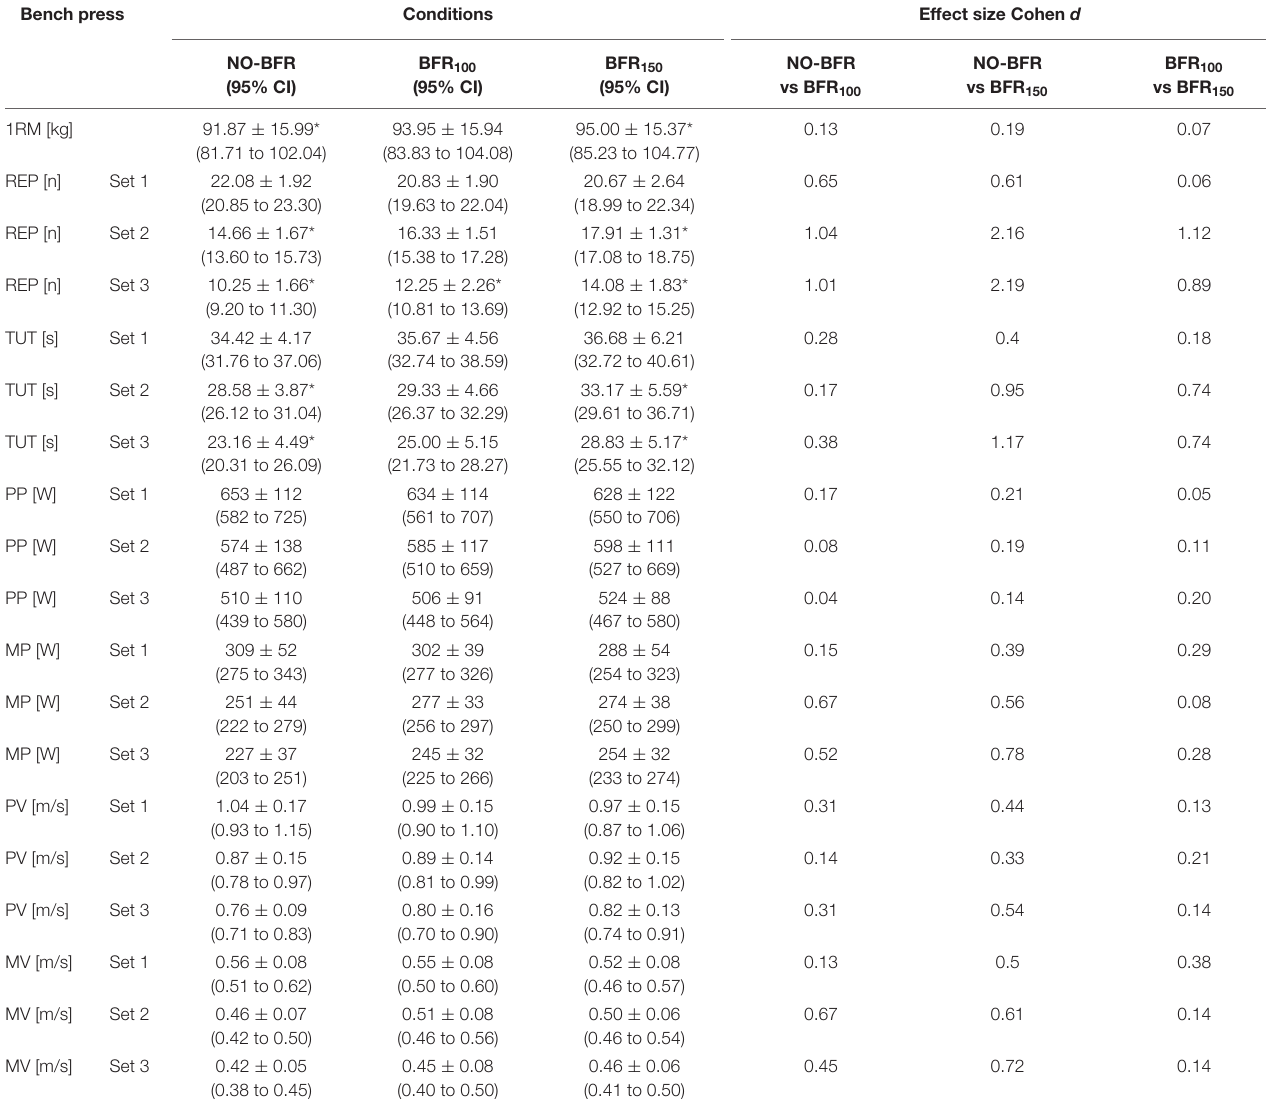
TABLE 2 | Differences in particular conditions between the 1RM test and the three experimental bench press sets. Bench